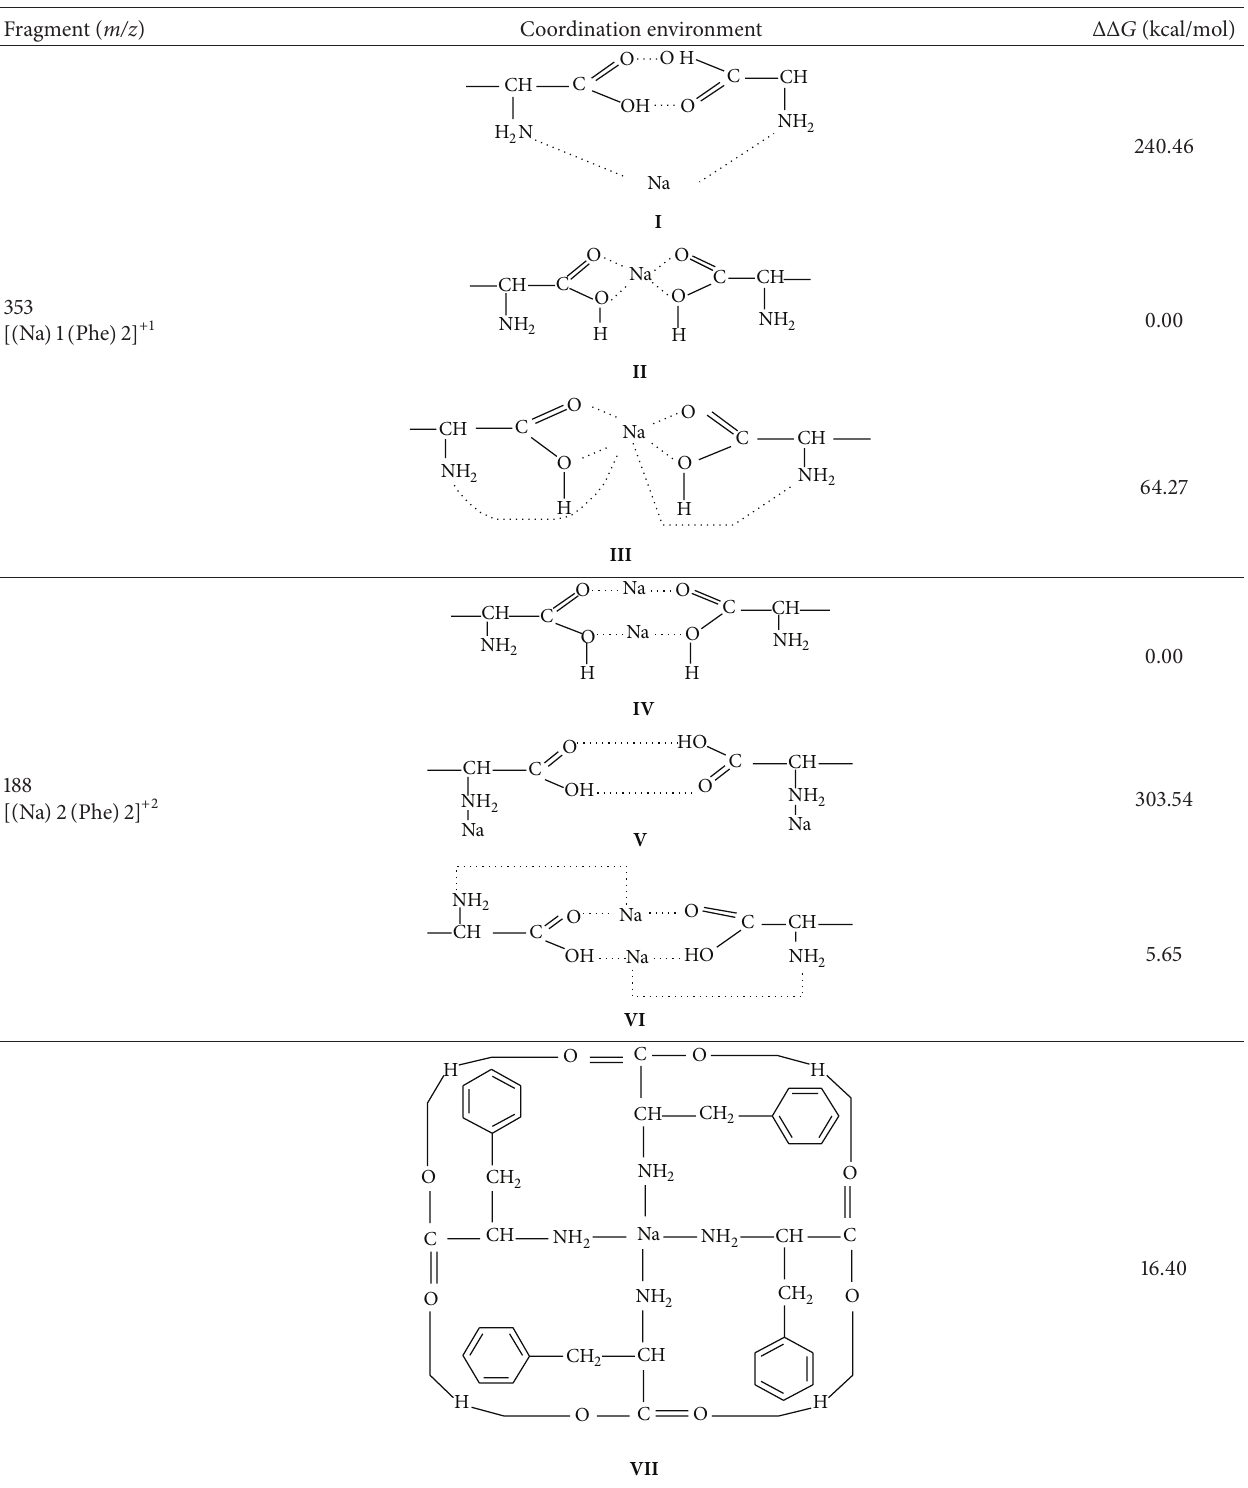
Table 1: Relative Gibbs free energy values obtained with proposed cation at the DFT